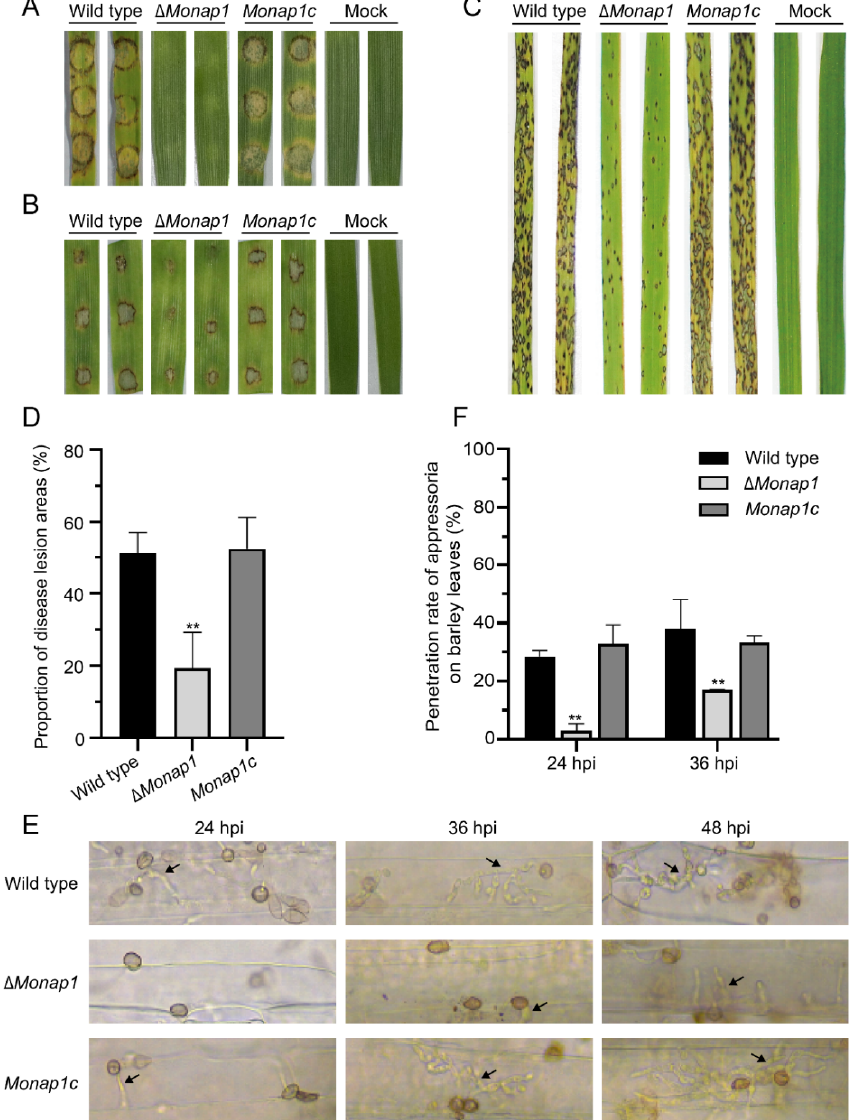
Figure 5. NAP1 is required for virulence. ( A ) Disease symptoms of leaf explants of barley inoculated with mycelial plugs from the wild-type, ∆ Monap1 and Monap1c strains. The pictures were photo- graphed at 4 dpi. ( B ) Disease symptoms of leaf explants of barley inoculated with spore suspensions (5 × 10 4 conidia mL − 1 ). ( C ) Two-week-old rice seedlings were inoculated by spraying 5 × 10 4 conidia mL − 1 conidial suspensions from the wild type, ∆ Monap1 and the complemented strain. Lesion sever- ity on rice leaves was evaluated at 7 dpi. ( D ) The proportion of disease lesion areas (%) caused by the wild type, ∆ Monap1 , and Monap1c strains on rice seedlings. The area occupied by disease spots per 5 cm of rice leaves was counted. At least 20 leaves were counted per replicate. n = 3 independent biological replicates. Error bars represent the standard deviations. The data were analyzed by GraphPad Prism 8.0 and significant differences compared with the wild type were estimated by multiple t tests: ** p < 0.01. ( E ) Invasive growth of M. oryzae. Barley leaf explants were inoculated with 20 μ L of conidial suspension (5 × 10 4 conidia mL − 1 ) and cultured for 24 h, 36 h, and 48 h. The arrows indicate invasive hyphae. ( F ) Penetration rate (%) of the wild type, ∆ Monap1 and Monap1c appressoria on barley leaves. At least 150 appressoria were counted per replicate. n = 3 independent biological replicates. Error bars represent the standard deviations. The data were analyzed by